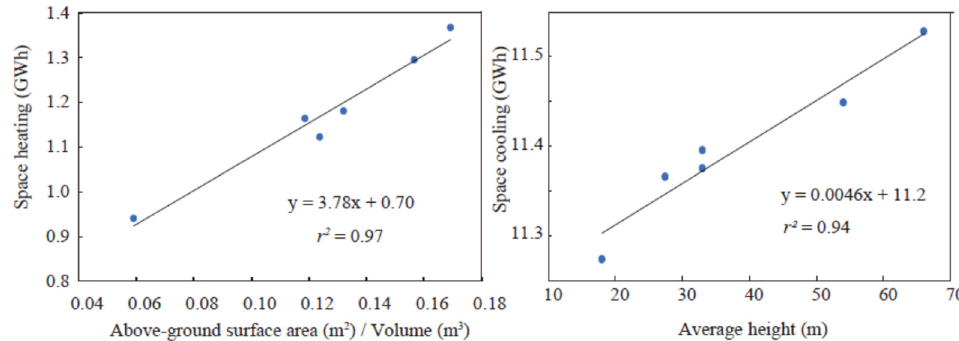
Figure 7. Influences of surface area/volume ratios and building heights on space heating ( left ) and cooling ( right ), respectively.